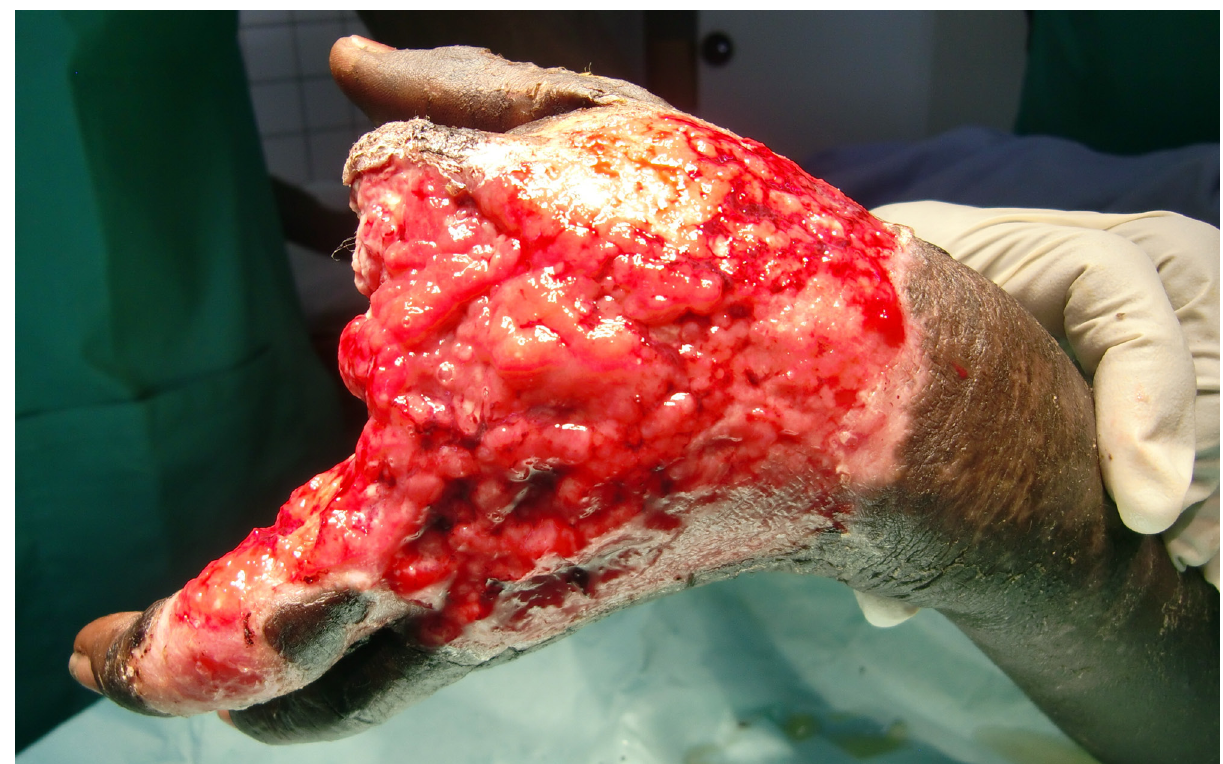
Figure 13. Clean aspect of the hand, after eight